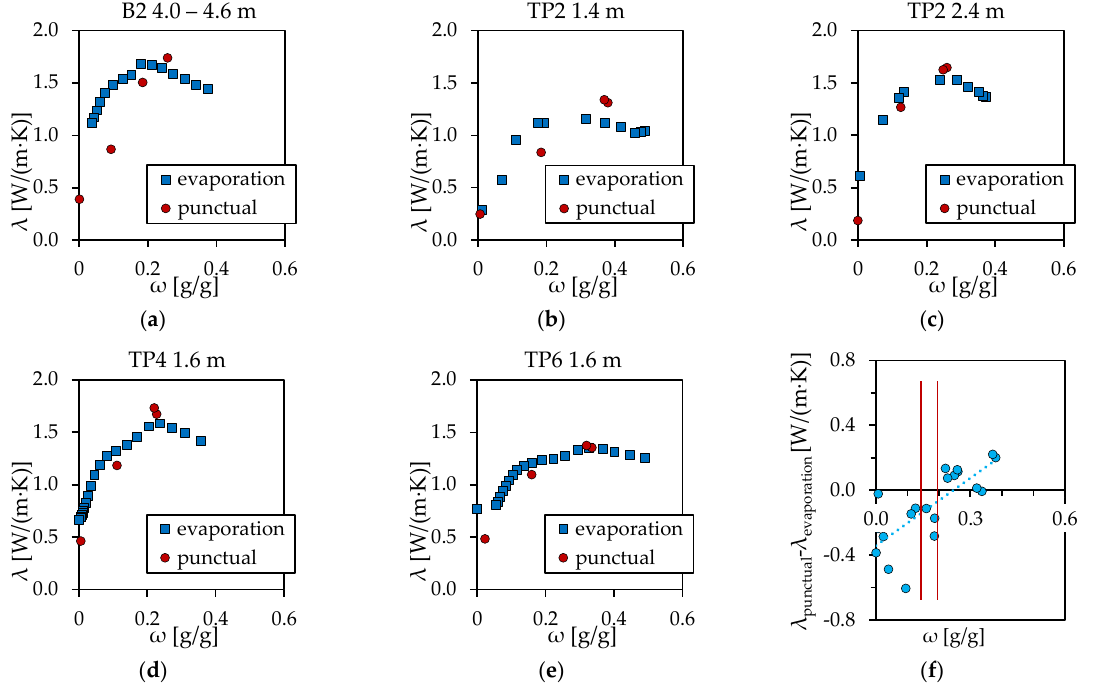
Figure 8. ( a – e ) Comparison of the results of the evaporation method and the punctual method. For the evaporation method, a maximum of one measuring point per 24 h is displayed; ( f ) correlation between the differences of measured values for λ with the punctual method ( λ punctual ) and the evap- oration method ( λ evaporation ) at matching values of ω . The two red lines represent the area, where ω S is located according to Table 6. If no measurement data was available at equal water contents, λ was linearly interpolated.